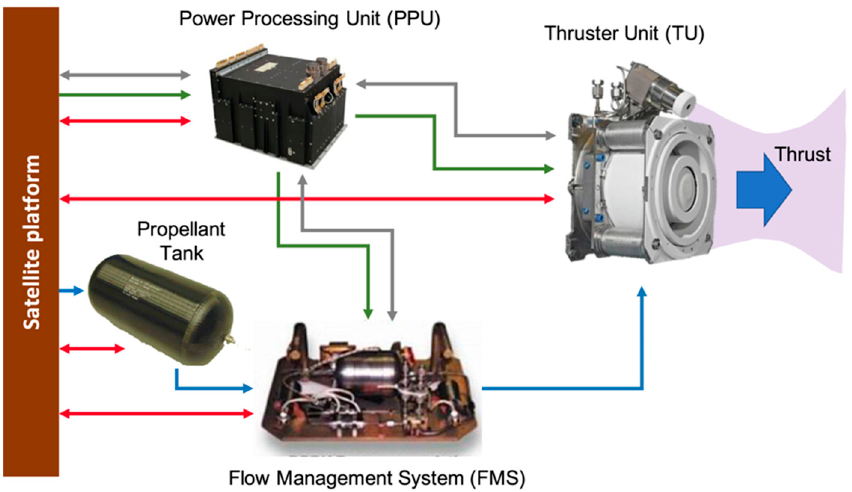
Figure 2. Simplified schematic of a typical electric propulsion (EP) configuration and connection between main elements (figure adapted from Lorand et al. [39]).